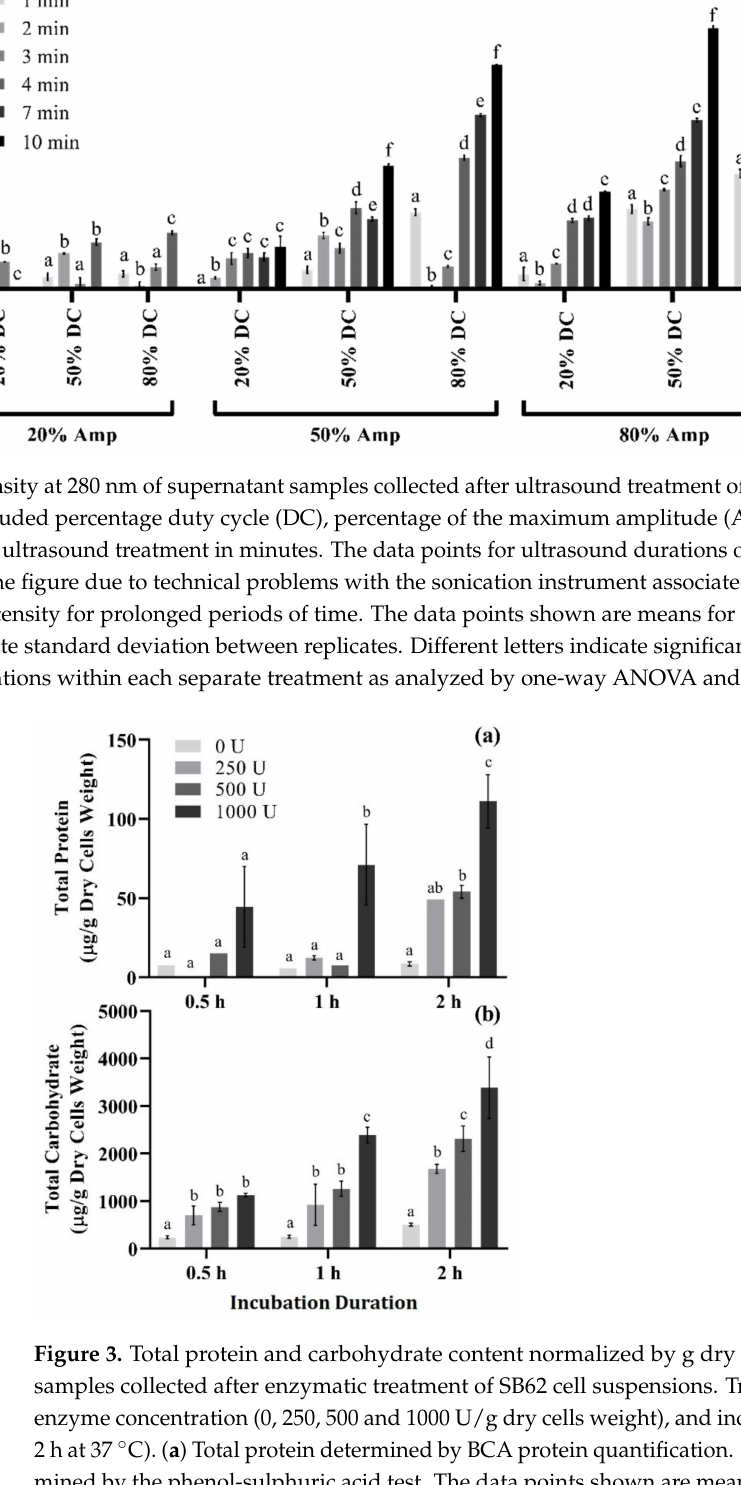
cells weight which were incubated for the longest duration of 2 h, did not exceed 111 µ g protein and 3389 µ g carbohydrate per g dry weight cells.